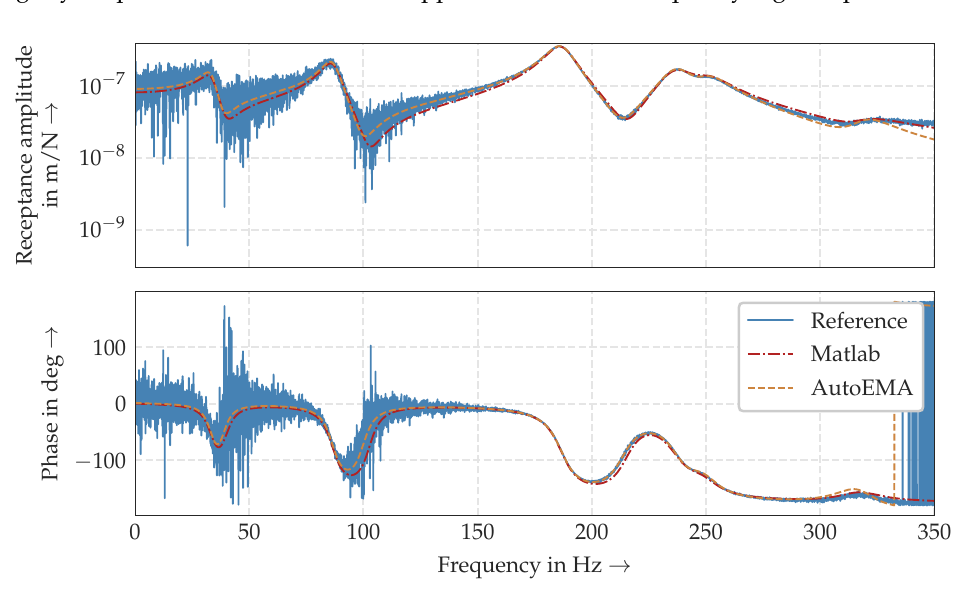
Figure 5. Comparison of the receptance amplitude and the phase between the input (solid) and the fitted FRF (AutoEMA: dashed, MATLAB ® : dash-dotted) from the modal model from a force f 1 to the displacement x 1 of the first mass; normal (Gaussian) noise was added to the (synthetic) displacement data to simulate noisy real-world